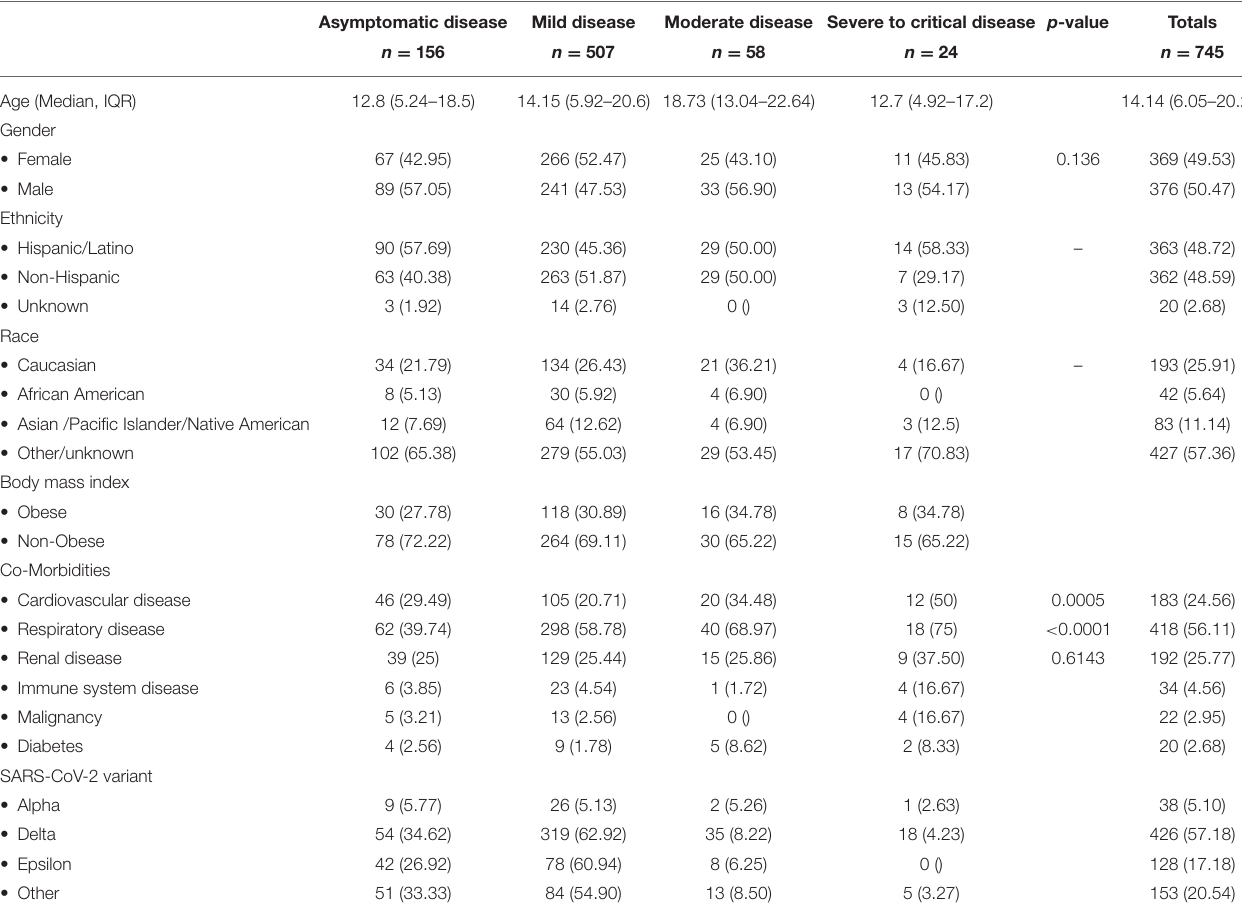
TABLE 1 | Characteristics of the patients at diagnosis by